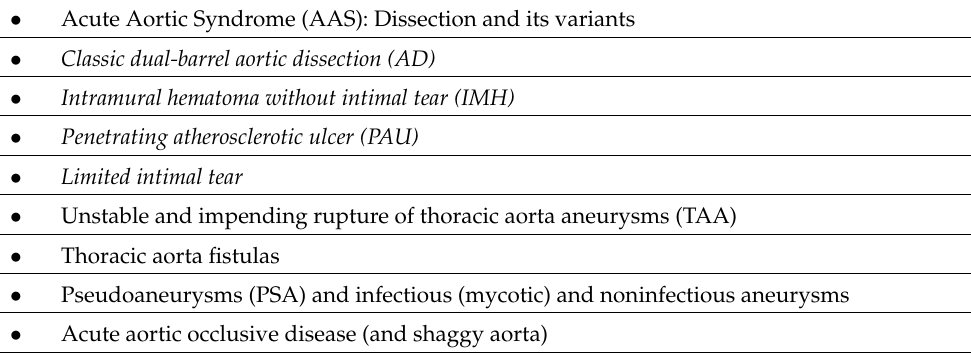
Table 1. Non-traumatic thoracic aortic